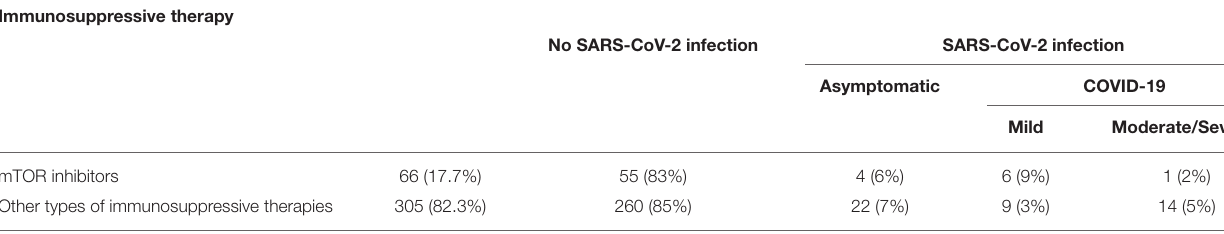
TABLE 6 | Immunosuppressive therapy evaluation: mTOR inhibitors vs. other types of immunosuppressive therapies. Immunosuppressive